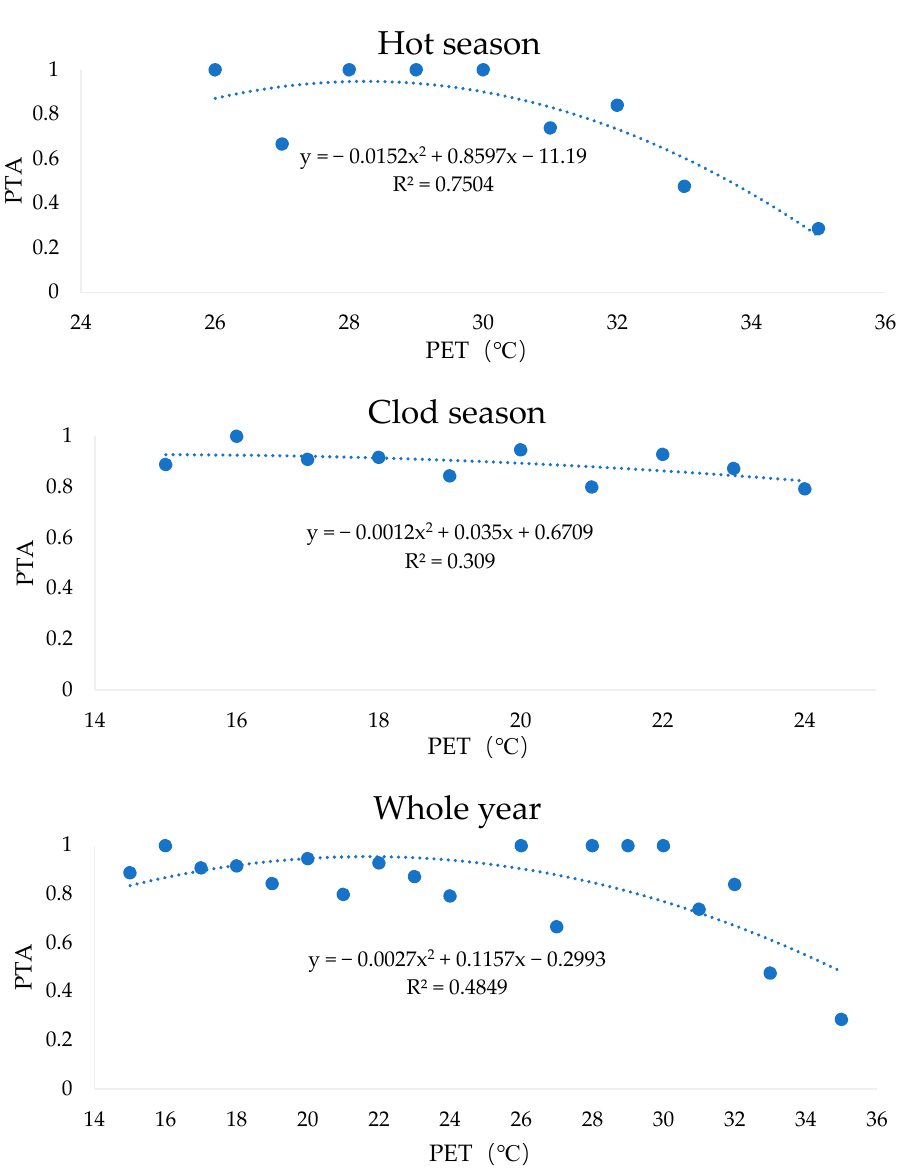
Figure 9. Relationship between PTA and PET.